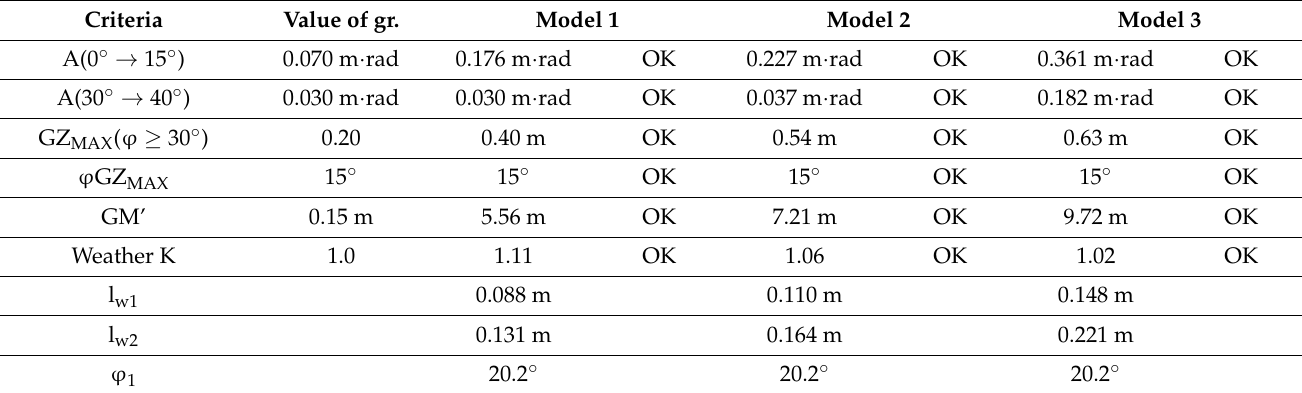
Table 3. Stability criteria ISC’2008,